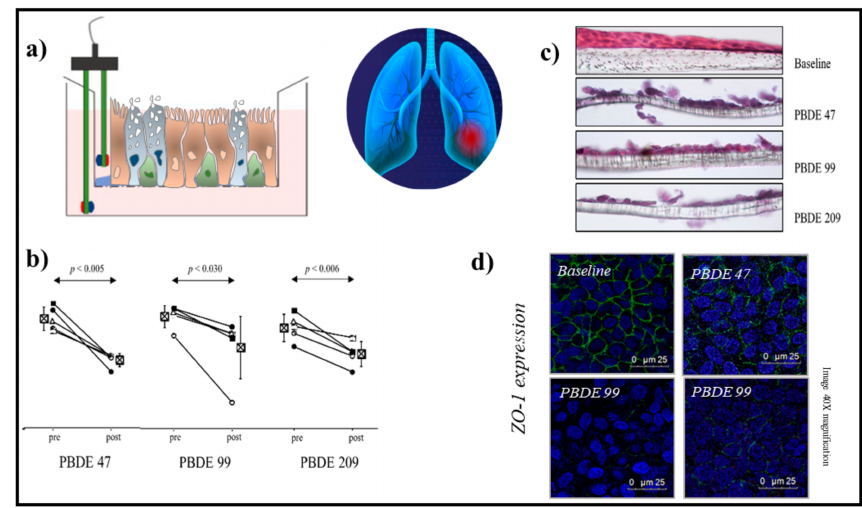
Figure 5. The measurement of TEER in the 3D ALI culture stimulated with air pollutants such as PBDE-47, -99, and -209 modifies the integrity of the epithelium of the lung, promoting airway diseases. ( a ) Electrode useful to measure the values of TEER in 3D cell culture; ( b ) reduction of TEER values before and after the treatment with contaminants of epithelial cells cultured in ALI; ( c ) morphological changes of epithelial cells cultured in ALI; ( d ) the damage of integrity of 3D epithelium is associated with a reduction of ZO-1